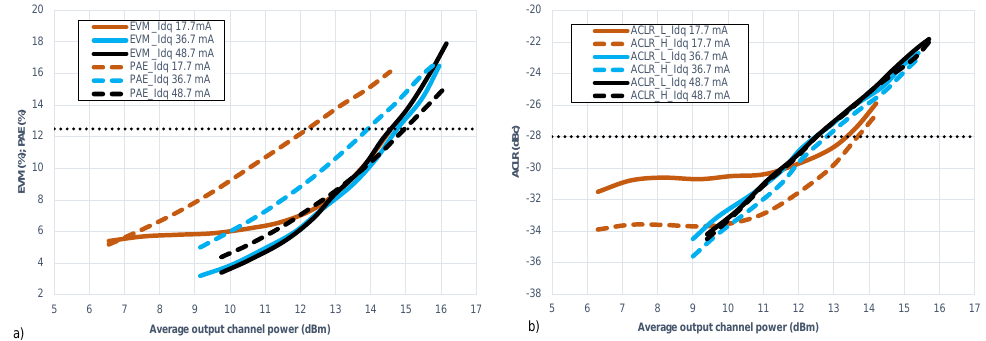
Figure 11. ( a ) EVM, PAE and ( b ) ACLR as a function of average output channel power at three different bias currents at 26 GHz using 100 MHz 16-QAM 3GPP/NR2 OFDM